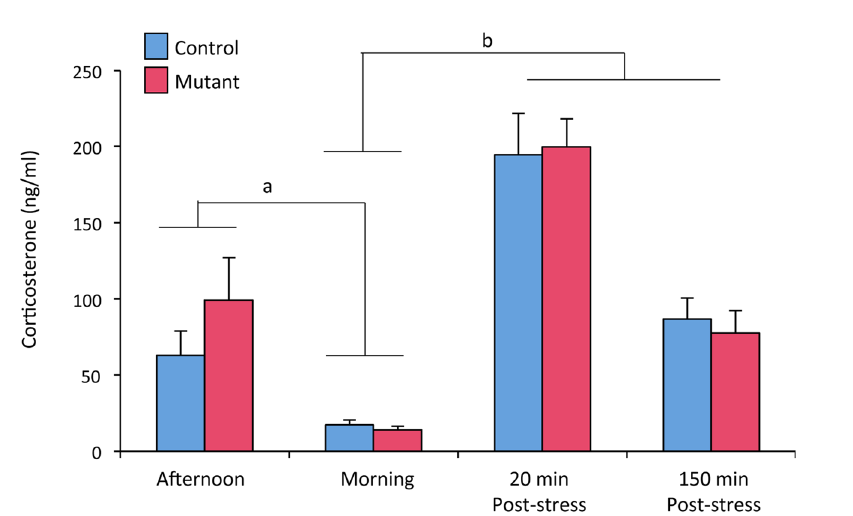
Figure 5. Corticosterone levels in control and mutant male mice. Corticosterone levels were measured in plasma samples collected in the afternoon and the following morning in control and mutant mice (n = 8–9 per genotype). They were then subjected to restraint stress and plasma was collected and measured for hormones 20 min and 150 min after the stress. a p < 0. 001 versus afternoon levels; b p < 0.001 versus morning